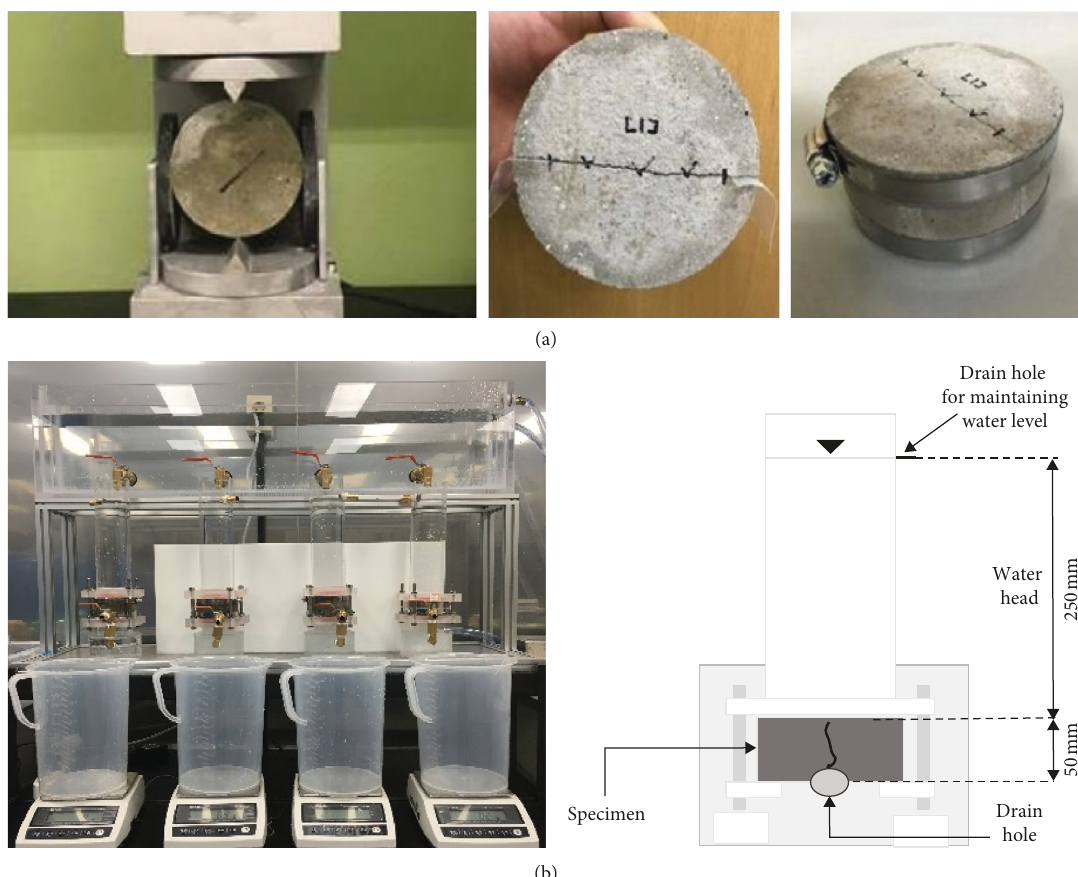
Figure 5: Preparation of cracked specimens for water permeability testing: (a) precracking; (b) water flow